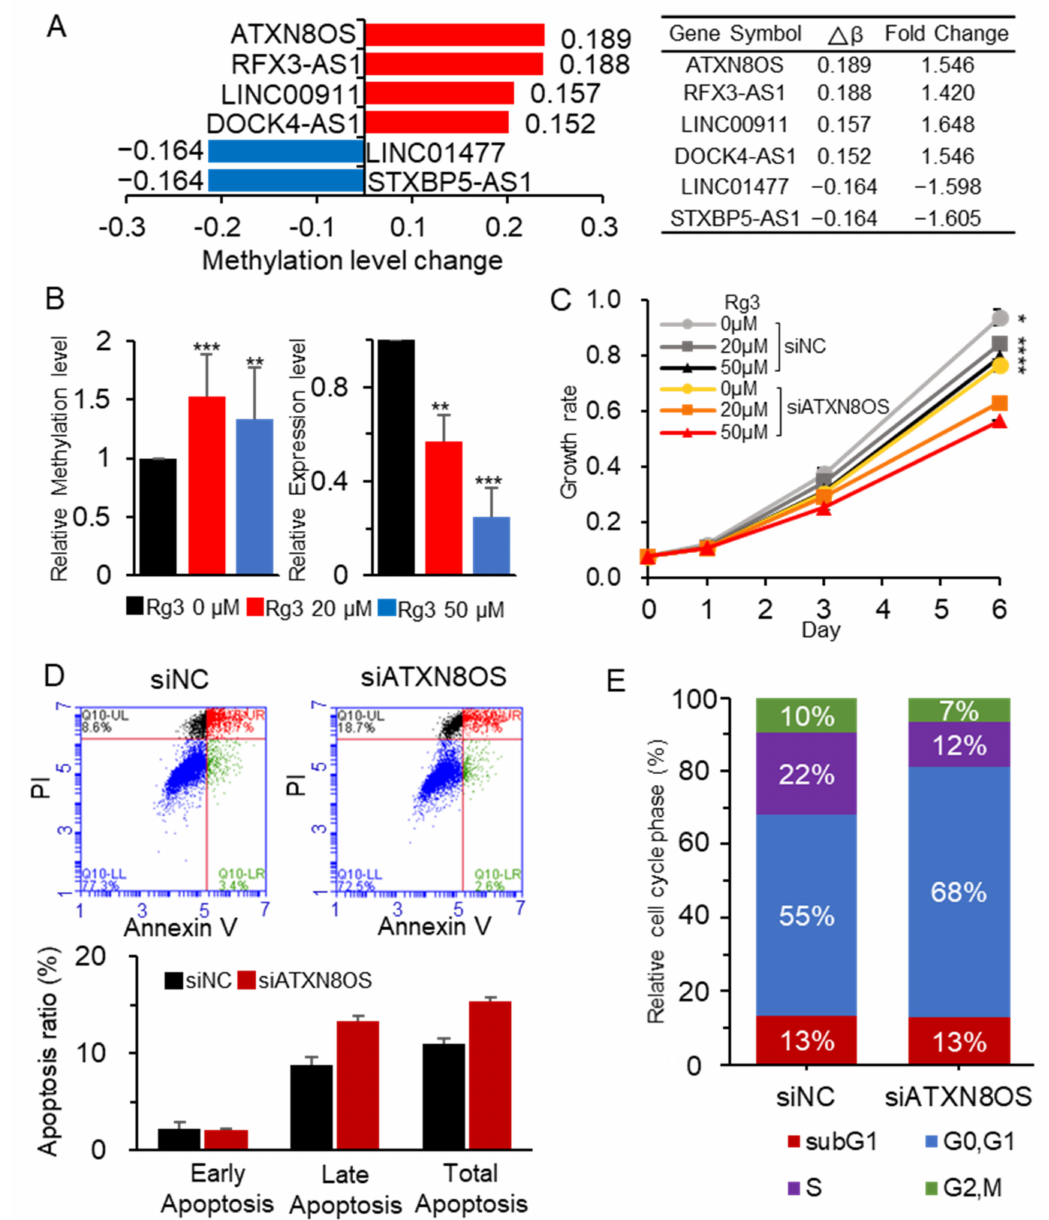
Figure 1. ATXN8OS with proproliferation activity in the MCF-7 cells was downregulated by Rg3 via promoter methylation. ( A ) ATXN8OS was among the six lncRNAs that exhibited significant changes in methylation level (| ∆ β | ≥ 0.15 and |fold change| ≥ 1.4), as demonstrated by the analysis of an Rg3-treated MCF-7-cell methylation array. ( B ) MCF-7 cells were treated with 20 and 50 µ M of Rg3, and the methylation and expression of ATXN8OS were examined by methylation-specific PCR and qRT-PCR, respectively. ( C ) ATXN8OS was downregulated in MCF-7 using siRNA, and its effect on cell proliferation was examined in the presence of Rg3 using the CCK-8 assay. ( D , E ) The effect of ATXN8OS on apoptosis ( D ) and cell cycle ( E ) was monitored using flow cytometry. All experiments were performed in triplicate, and the values are presented as the mean ± SE. siNC, control siRNA (40 µ M); siATXN8OS, ATXN8OS-specific siRNA (40 µ M). * p < 0.05, ** p < 0.01, *** p <